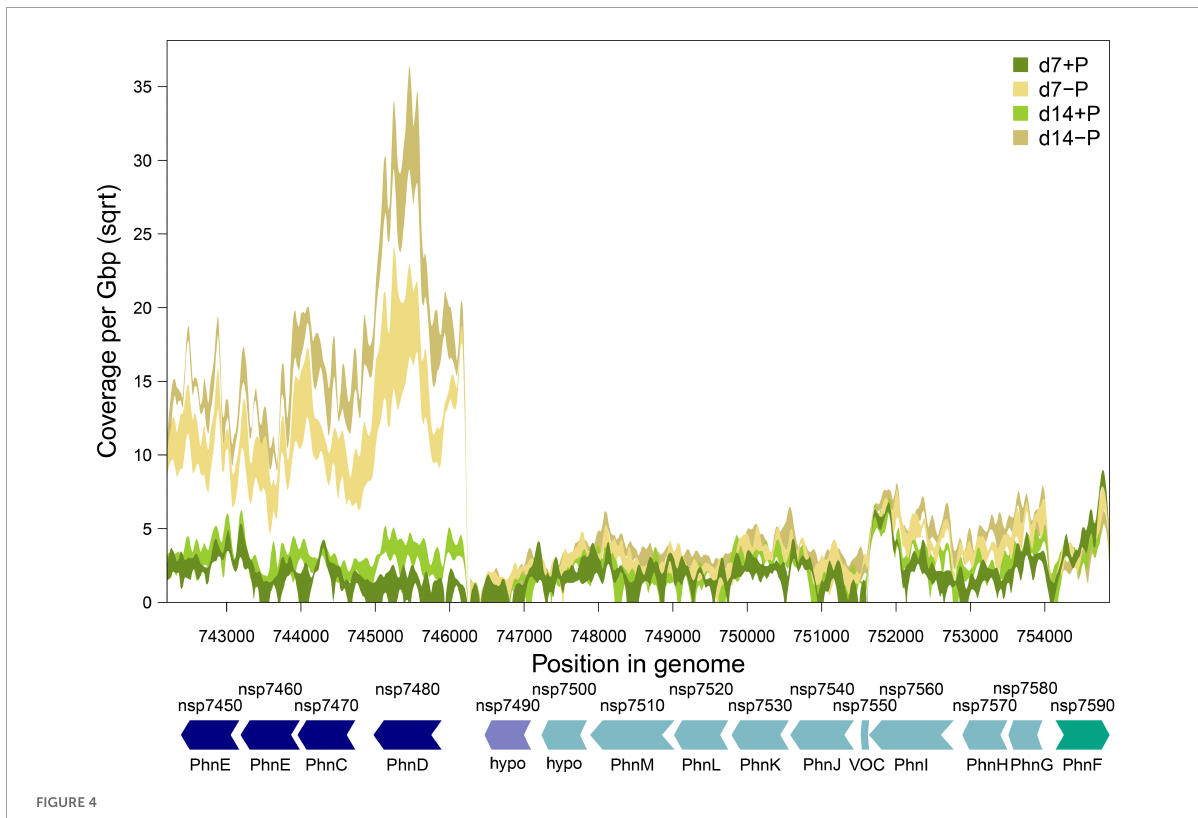
FIGURE4 Gene expression of phosphate-regulated gene cluster nsp7450 to nsp7590 in N. spumigena CCY9414 under P-replete (+P) and P-deplete (–P) conditions. Shaded bands show minimum and maximum gene expression (normalized as square-root transformed per base pair coverage per Gbp sequencing effort) at each experimental condition. Arrows indicate gene arrangement and orientation and were colored according to operon assignment as provided in Table 1 . Locus tags and gene names are according to Table 1 (hypo: hypothetical